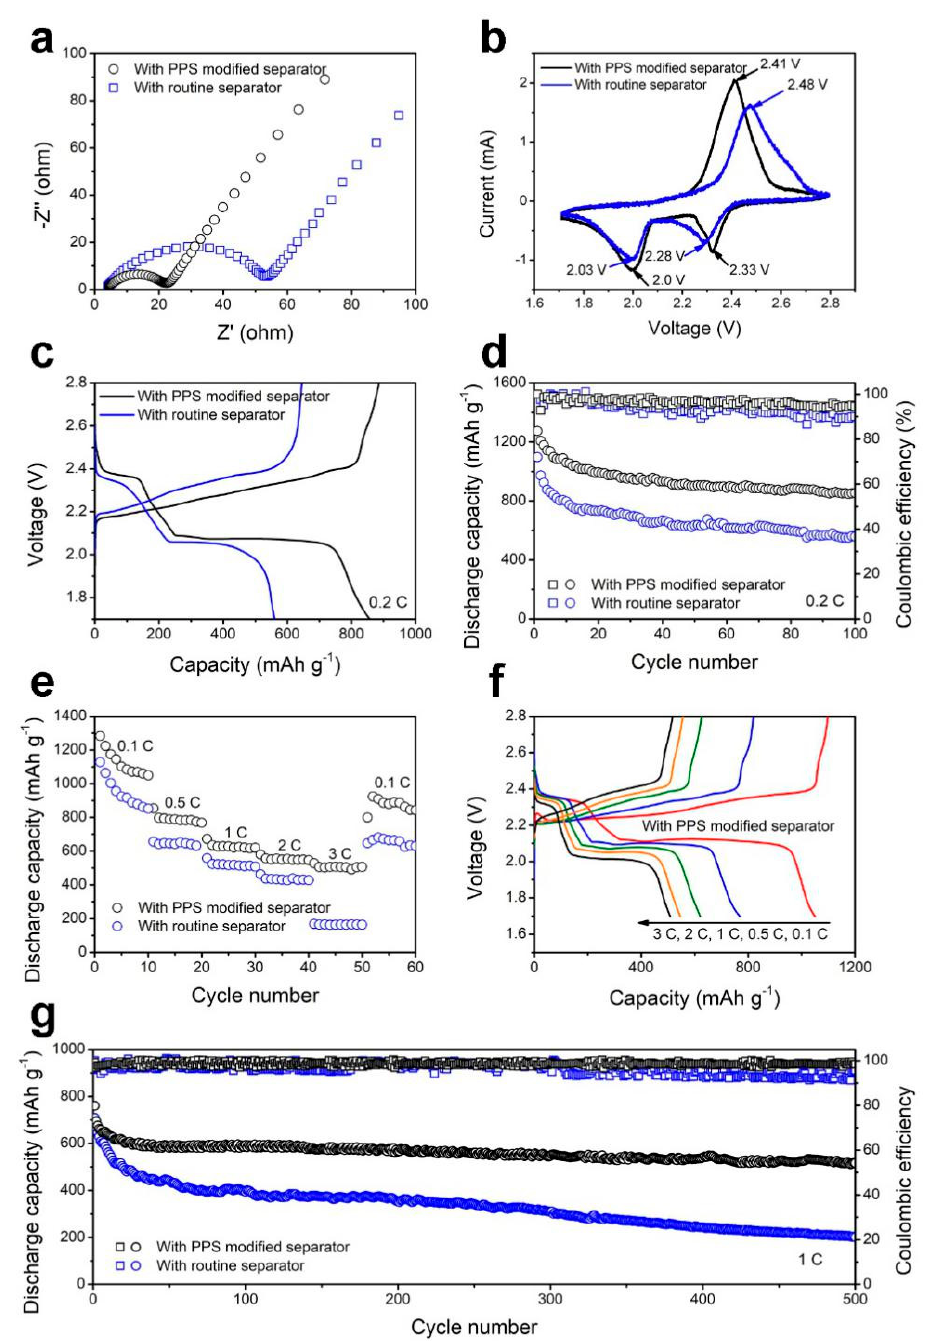
Figure 6. ( a ) EIS spectra; ( b ) CV profiles; and ( c ) charge-discharge curves of Li-S cells with the PPS-modified separator and the routine separator; ( d ) Cycling performance of Li-S cells with the PPS-modified separator and the routine separator at 0.2 C; ( e ) Rate performance of Li-S cells with the PPS-modified separator and the routine separator; ( f ) Charge-discharge curves of Li-S cells with the PPS-modified separator at various rates; ( g ) Long-term cycling performance of Li-S cells with the PPS-modified separator and the routine separator at 1 C.